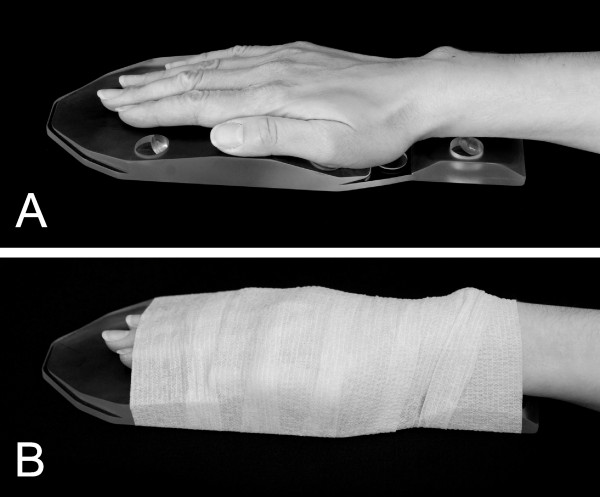
Positioning device used for reproducible alignment of the bones and joints of the hand and wrist during serial magnetic resonance imaging. (A) Hand and wrist are shown positioned on the acrylic M-frame™ with the fingers and thumb adducted and in plane with each other. (B) The hand and wrist are secured to the frame with self-adhesive, latex-free, elastic bandage (images courtesy of Spire Sciences, Inc).